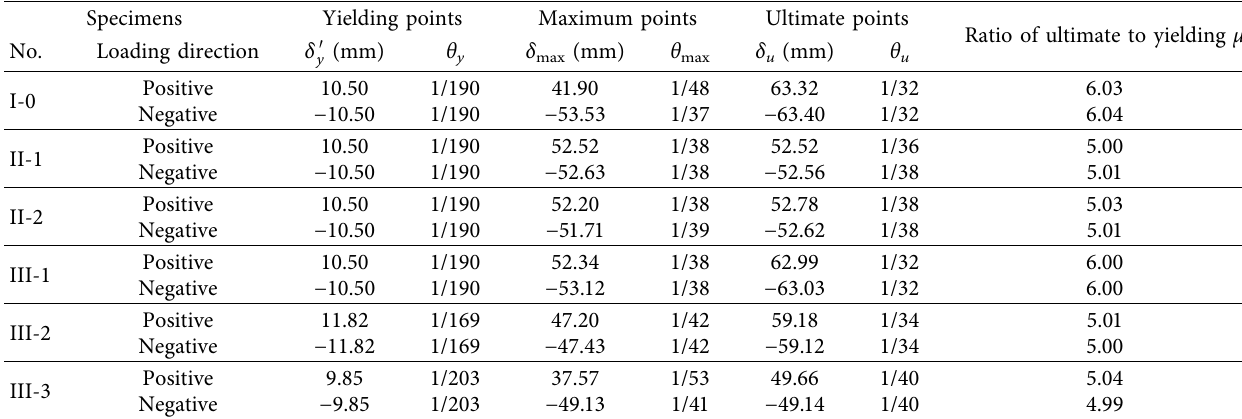
Figure 14: Skeleton curves of typical specimens. (a) Impacts of energy-dissipating plates. (b) Impacts of the thickness of energy-dissipating plates. (c) Impacts of axial compression ratio. Table 4: Displacement ductility